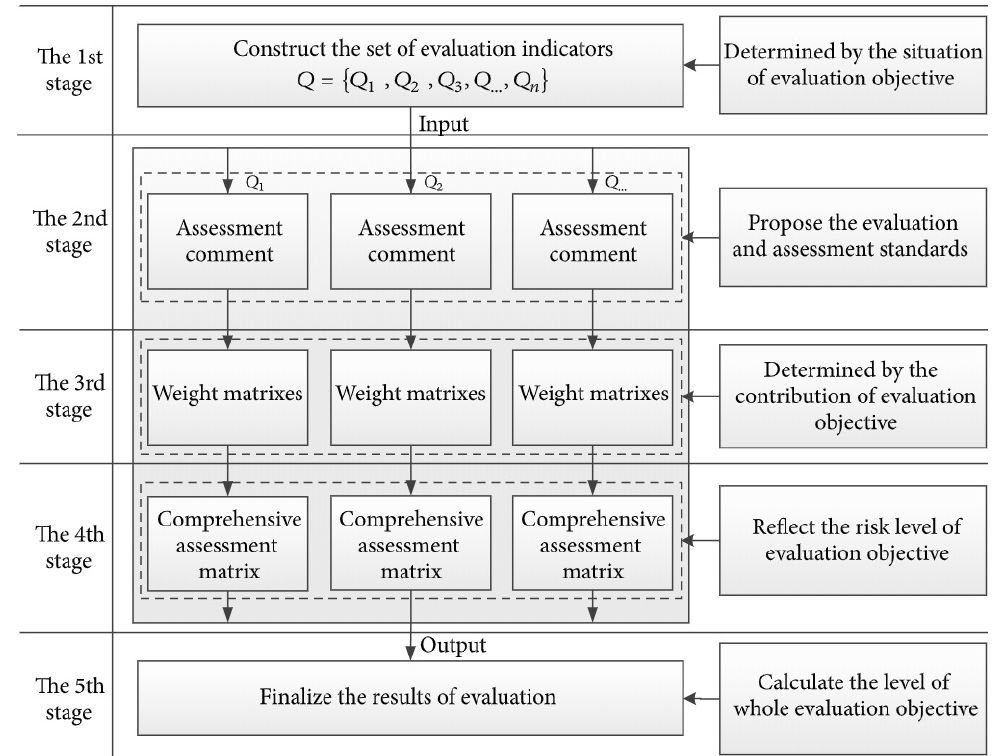
Fig. 2 Process of FCE method. FCE, fuzzy comprehensive